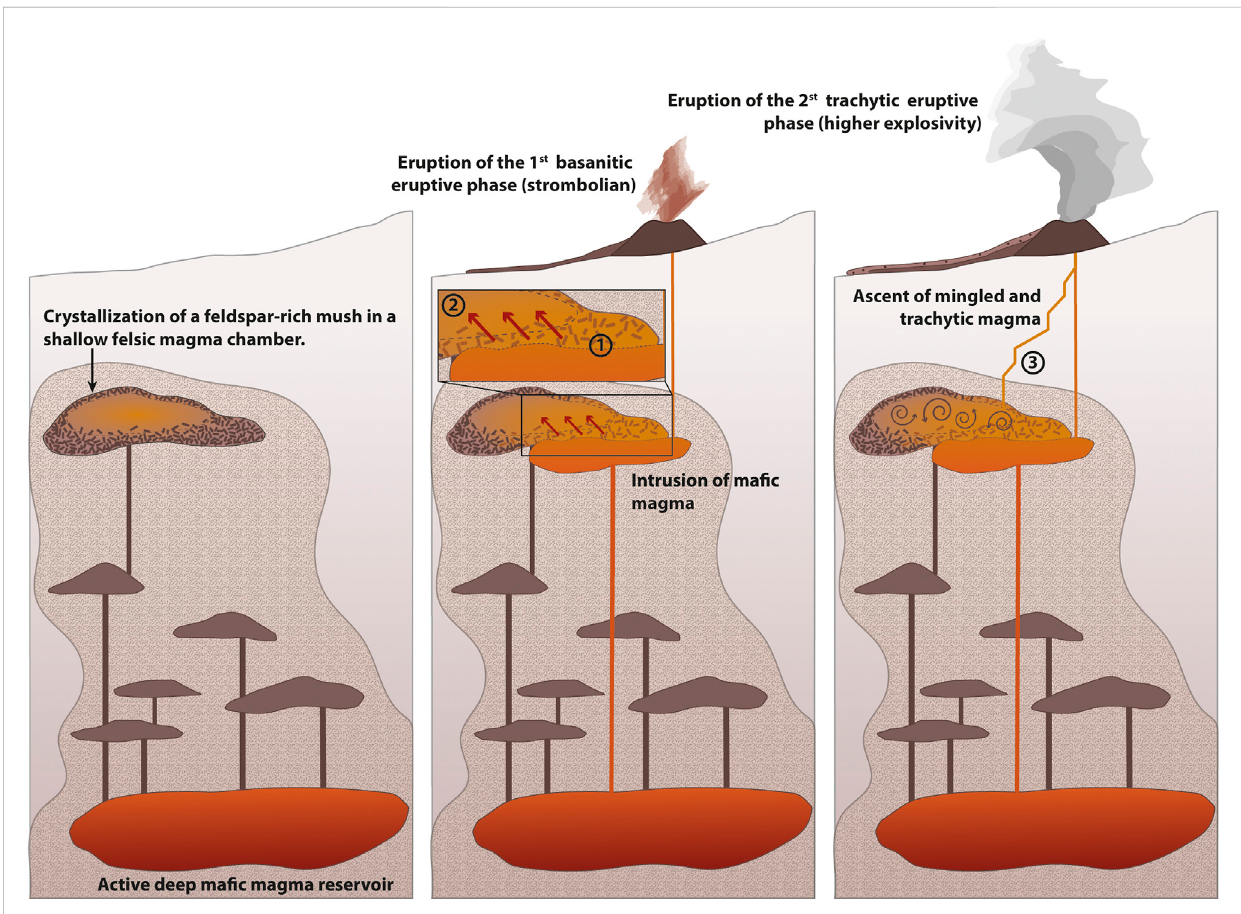
FIGURE 13 Simpli fi ed schematic illustration of Montaña Reventada plumbing system, showing pre-eruptive and syn-eruptive processes. Not to scale. 1) Mixing of the basanite with the phonolitic magma and crystallisation of Type 4 and 5 feldspars (different compositions resulting from the different degrees of hybridisation).2)Partialmeltingofthecrystalmush,escapeofthemeltintotheinteriorofthereservoirandmixingwiththepreviousfelsicmelt,producing thenewtrachyticmagmaandcrystallisationofType1feldspars.3)Destabilisationoftheshallowmagmachamberduetothenewenergyinput,rapid ascent and emptying of the reservoir. Growth of the most evolved rims and microlites (with high Or and low